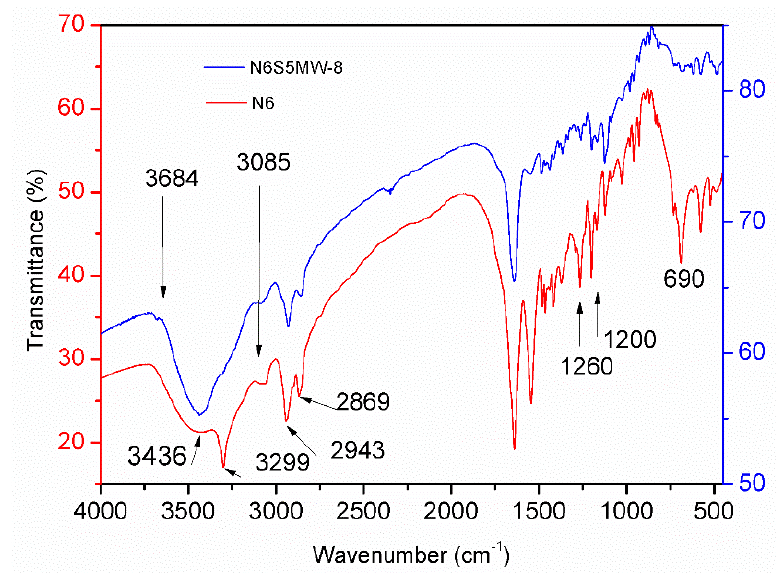
Figure 9. FT-IR spectra of samples N6 and N6S5MW-8. Table 2. FT-IR bands positions (cm −1 ) and ascriptions of N6 and N6S5MW-8.